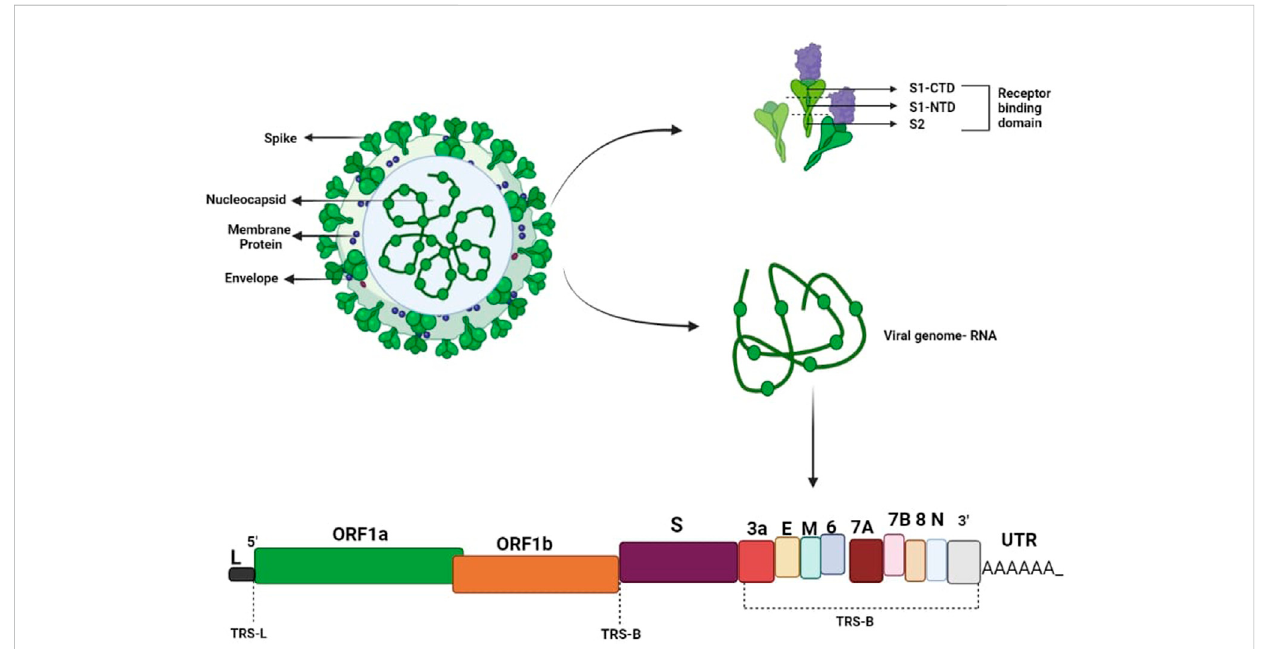
SARS-CoV-2 virus. A functioning polybasic cleavage site at the S1 – S2 junction of the spike protein and the receptor-binding domain (RBD) in the S1 subunit are two important genetic traits of